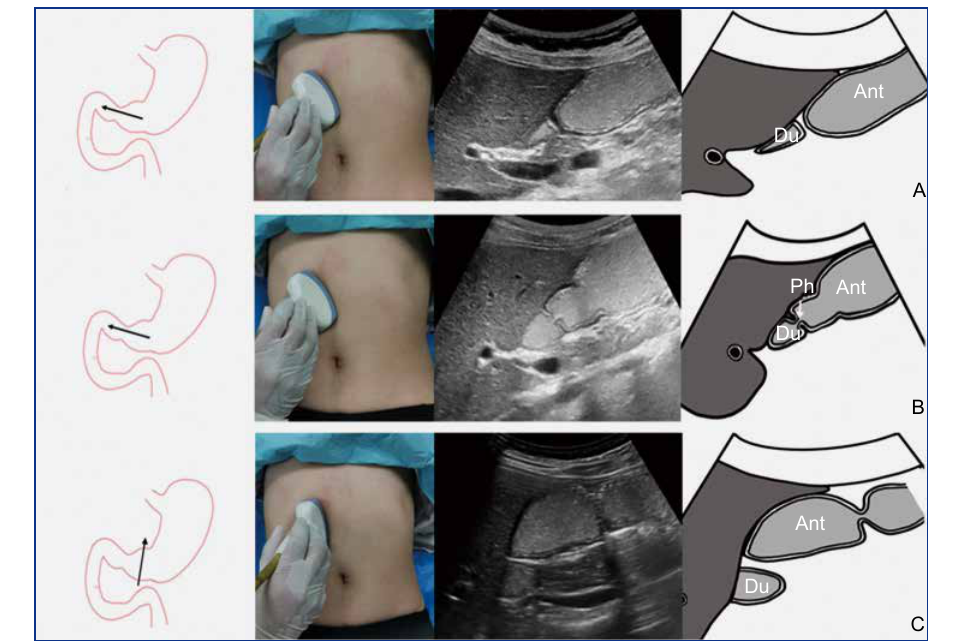
Figure 5 The imaging sections of the antrum and duodenal bulb. (A) The long axis view of antrum (Oblique section of right upper abdomen in supine position); (B) The long axis view of antrum, pylorus and duodenal bulb (oblique section of right upper abdomen in supine position); (C) The short-axis view of antrum (transverse section of right upper abdomen in supine position). Ant, antrum; Ph, pylorus hole; Du, duodenal